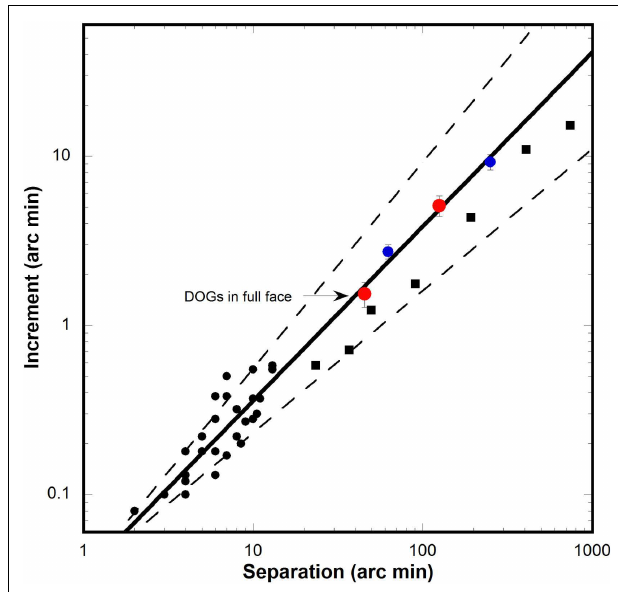
FIGURE 5 | Separation discrimination data from current and past studies. Black circles: discrimination increment thresholds for horizontal separation of two vertical bars from three studies (Westheimer and McKee, 1977;Watt and Morgan, 1983;Westheimer, 1984). Solid line: power function fitted to vertical bar data (followsWeber’s law). Dashed line: 95% confidence intervals for power function. Red circles: threshold for DOGs alone at 125arcmin (upper circle) and threshold from full face condition at mean horizontal distance to nose (45.4arcmin). Blue circles: threshold for DOGs alone at 62.5 and 250arcmin. Black squares: data for discrimination of vertical separation of two horizontal bars (Burbeck,